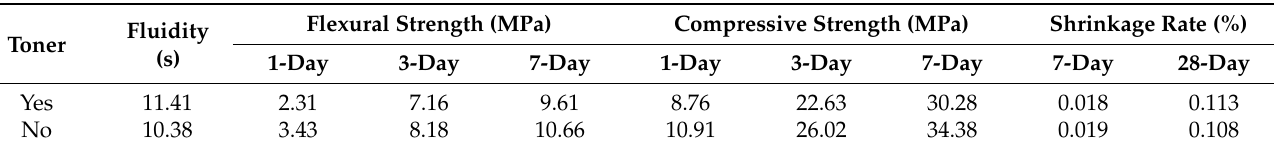
Table 3. The performance of cement grouting materials with toner.